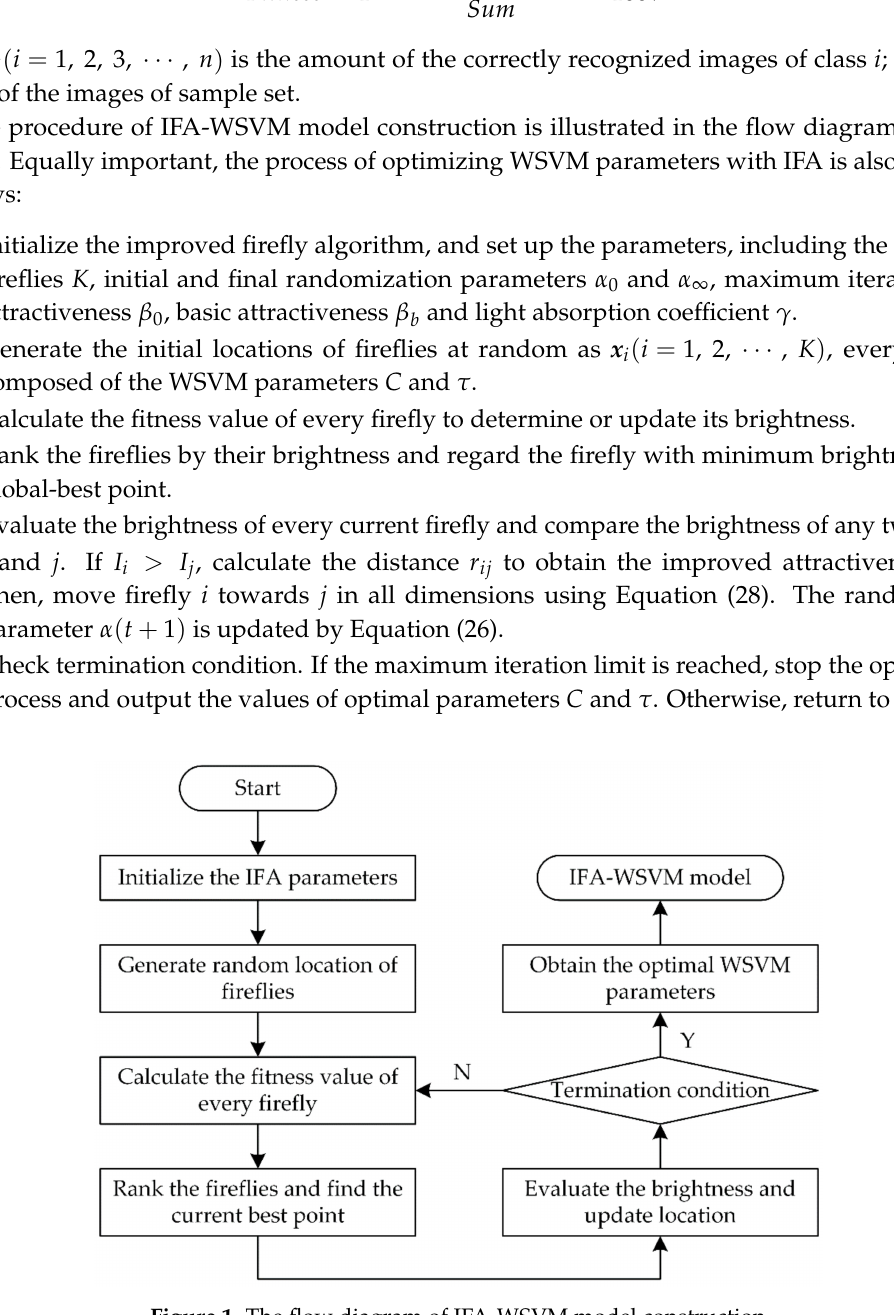
Figure 1. The flow diagram of IFA-WSVM model